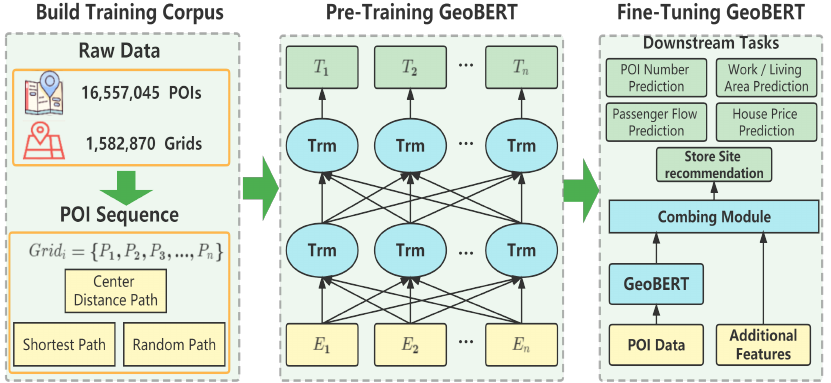
Figure 1. The overall framework of this study consists of three parts. The part on the left side shows how we construct pre-training corpora based on POIs and Geohash Grids. The middle part shows the model structure, which is based on the BERT structure. E represents the input embedding, Trm refers to a transformer block, and T represents the output token. On the right side is the fine-tuning module. We design five practical downstream tasks. The grid embedding learned from GeoBERT can be directly used for fine-tuning or combined with other